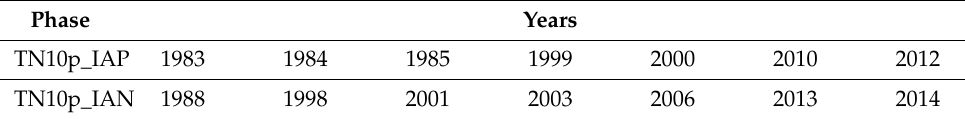
Table 2. Years with TN10p_IAP and TN10p_IAN phases of TN10p_IA.